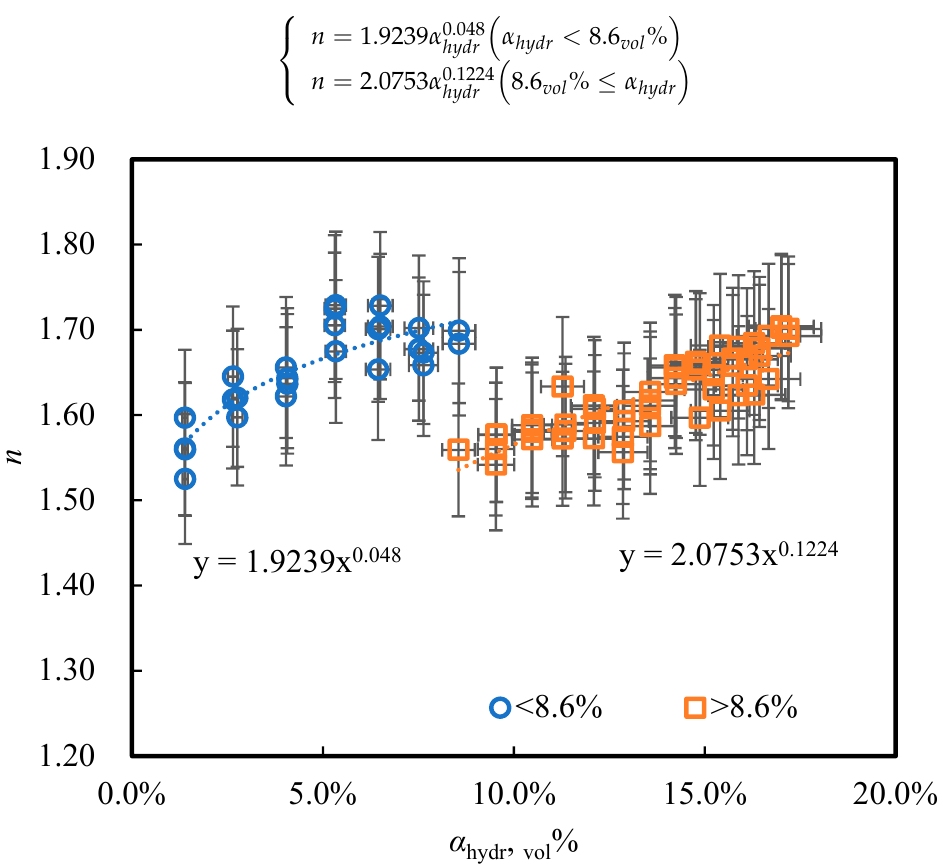
Figure 7. Evolution of the non-Newtonian index n of a function of volumetric hydrate fraction for CO 2 hydrate slurry.